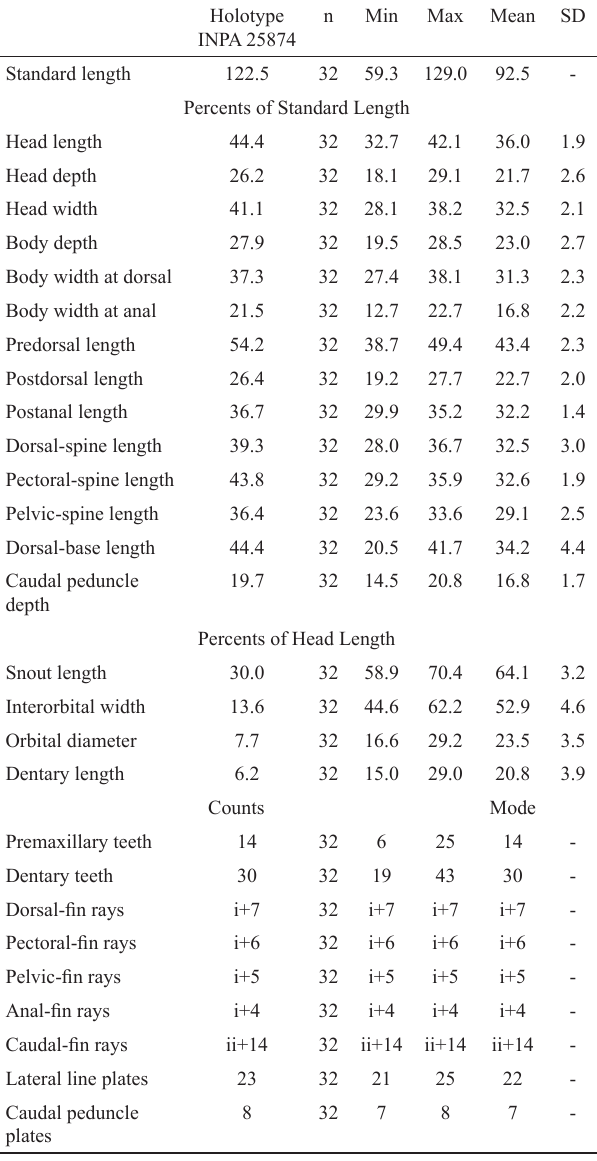
Table 5. Morphometric and meristic data of Spectracanthicus zuanoni . Values are given as percents of standard length or head length. SD = standard